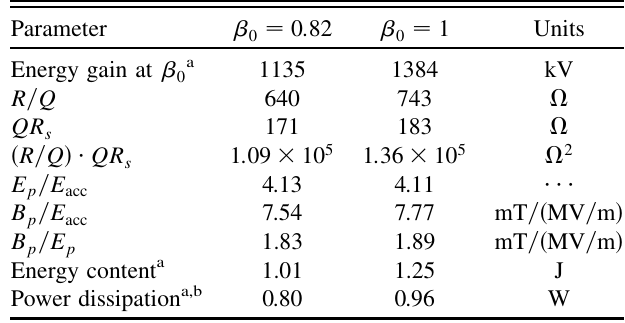
TABLE VI. Radio-frequency properties, 325 MHz, (cid:1) 0 ¼ 0 : 82 and (cid:1) 0 ¼ 1 cavities optimized for higher shunt impedance.